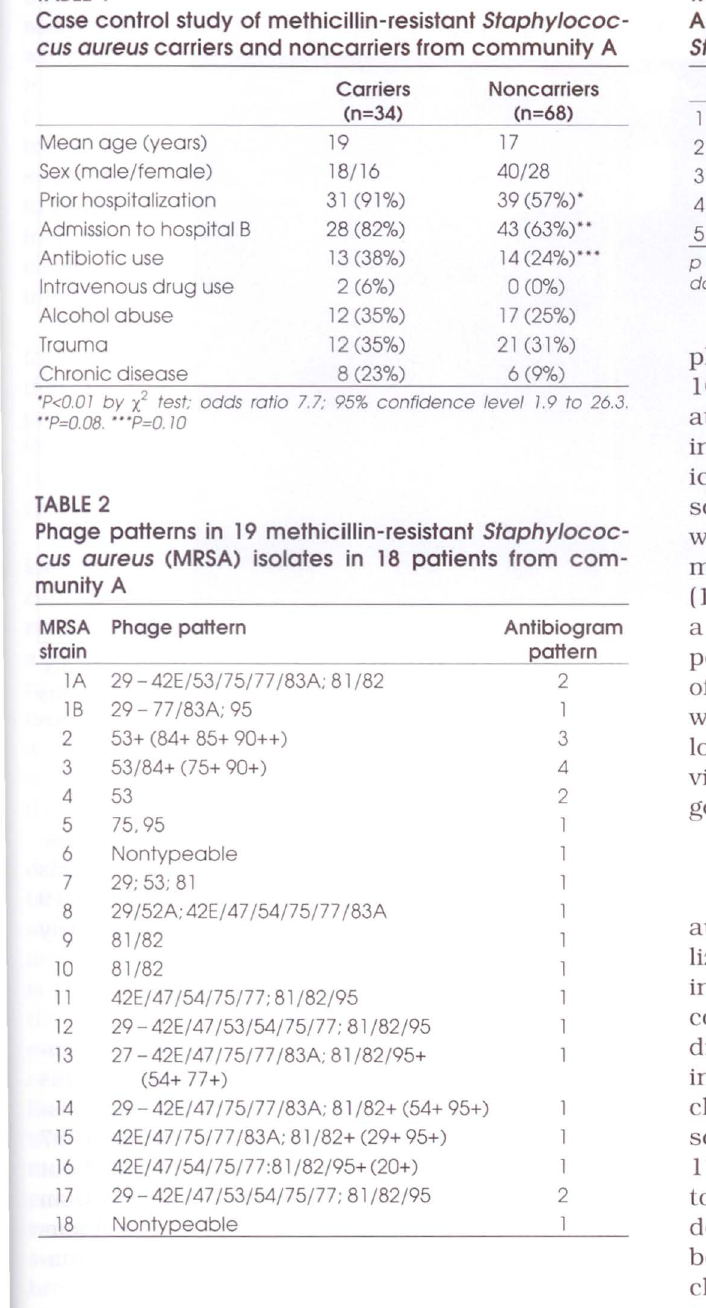
Antibiotic resistance patterns in 34 methicillin-resistant Staphylococcus aureus